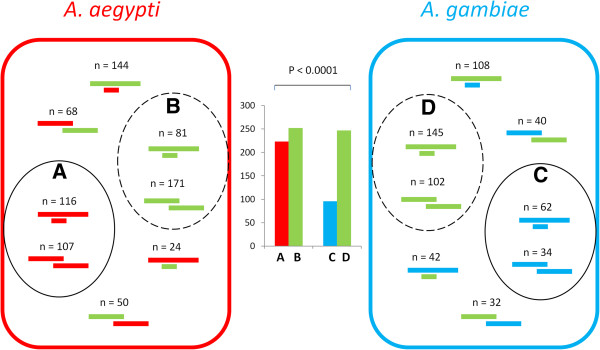
Orthology (one-to-one) of overlapping gene pairs between A. aegypti and A. gambiae. Genes have been color coded to represent orthologous relationships between the two species: red color represents A. aegypti and blue color represents A. gambiae. The one-to-one orthologous gene pairs that are localized in positionally overlapping manner in both the genomes are indicated by green color. The number of gene pairs is shown for each group. The circles A and C represent the young-young gene pairs, circles B and D represents the old-old gene pairs, and the gene pairs outside the circles represent young-old gene pairs in each species. The 2x2 contingency tests based on the count statistics of young-young and old-old genes between A. aegypti and A. gambiae (i.e. the A, B, C and D gene groups) shows that there is a significant bias in the distribution of these genes between the two species (shown as the column graph in the middle). In this graph, the y-axis shows the number of gene pairs corresponding to the four gene groups; and the gene groups are represented by the x-axis. The columns are color coded same manner as that of the gene groups (A, B, C and D).